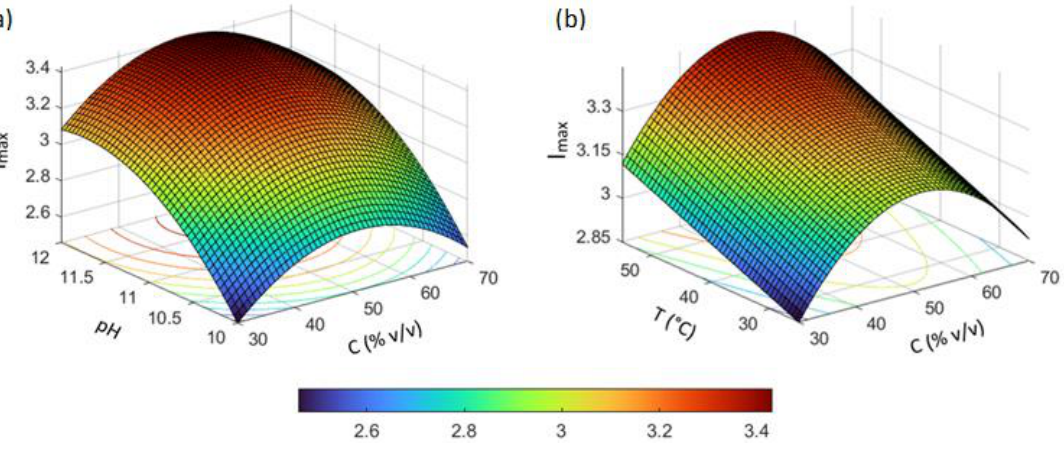
Figure 6. Representative response surface plots showing the effects on the intensity of the SPR band ( I max ) of: ( a ) pH and solvent composition (C); ( b ) temperature (T) and solvent composition (C). For each plot, the levels of the other factors were fix at their central values (C = 50% v / v ; R = 5 mol/mol; T = 40 ◦ C; pH =